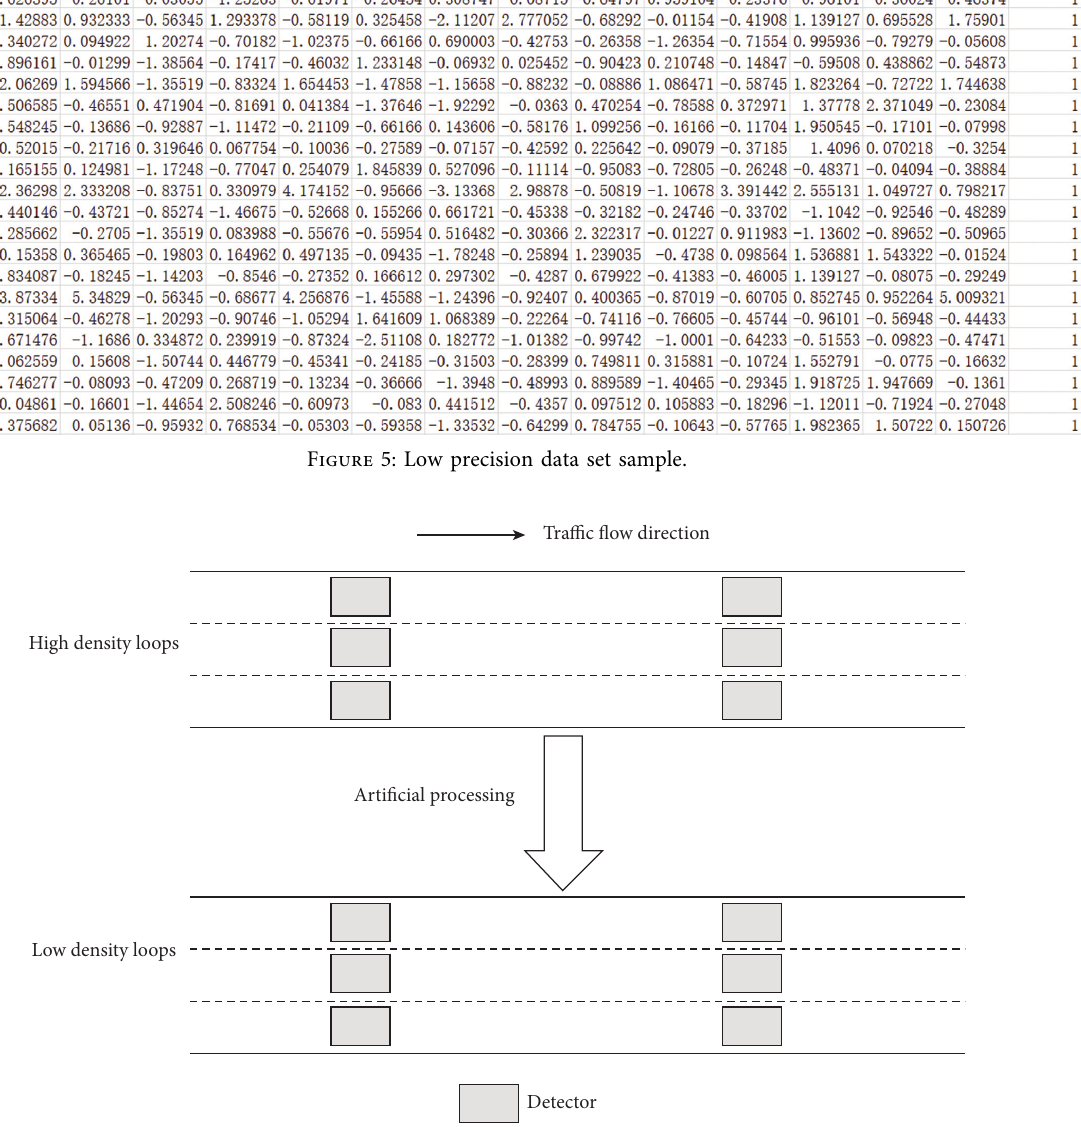
Figure 6: Schematic diagram of freeways with different loop densities.